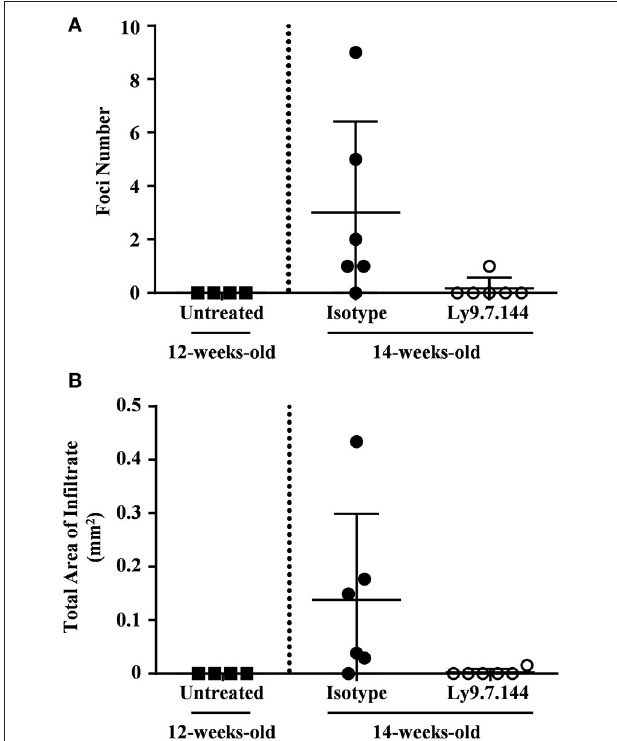
FIGURE 6 | Early administration of anti-Ly9 prevents the apparition of salivary gland cell infiltrates. The foci numbers are compared (A) between untreated 12-weeks-old female NOD.H-2 h4 (black squares) and 14-weeks-old female NOD.H-2 h4 mice that received a single dose of Ly9.7.144 (empty dots) or isotype control (black dots) for a period of 2 weeks. Same comparison is made with the total area of infiltrate (B) . The foci was defined as the presence of > 50 infiltrating leukocytes in continuum space. Results are expressed as mean ± SD. (unpaired two-tailed t -test). Data is from one independent experiment (A,B)